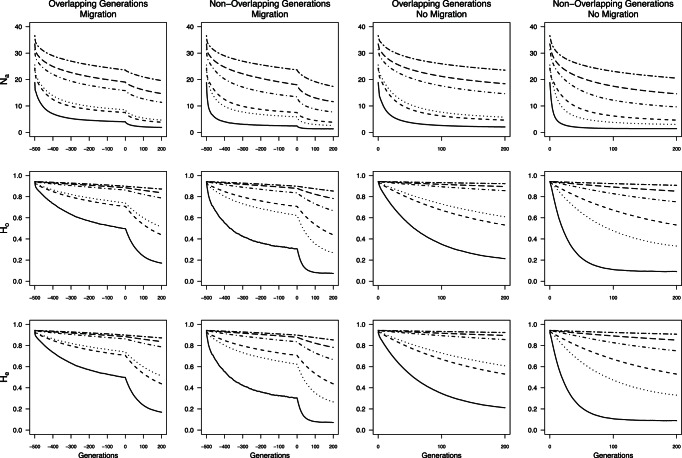
Values of Na, Ho, and He for 20 loci and all individuals across all simulation conditions.Lines from top to bottom represent the N
max’s of 3000, 1000, 500, 100, 75, and 25 individuals.